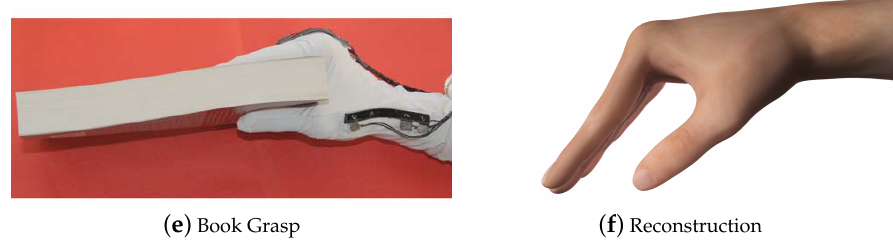
Figure 7. Comparison between real and reconstructed grasps (obtained from the five measurements extended to the 19-DOF pose and rendered in 3D Studio Max).